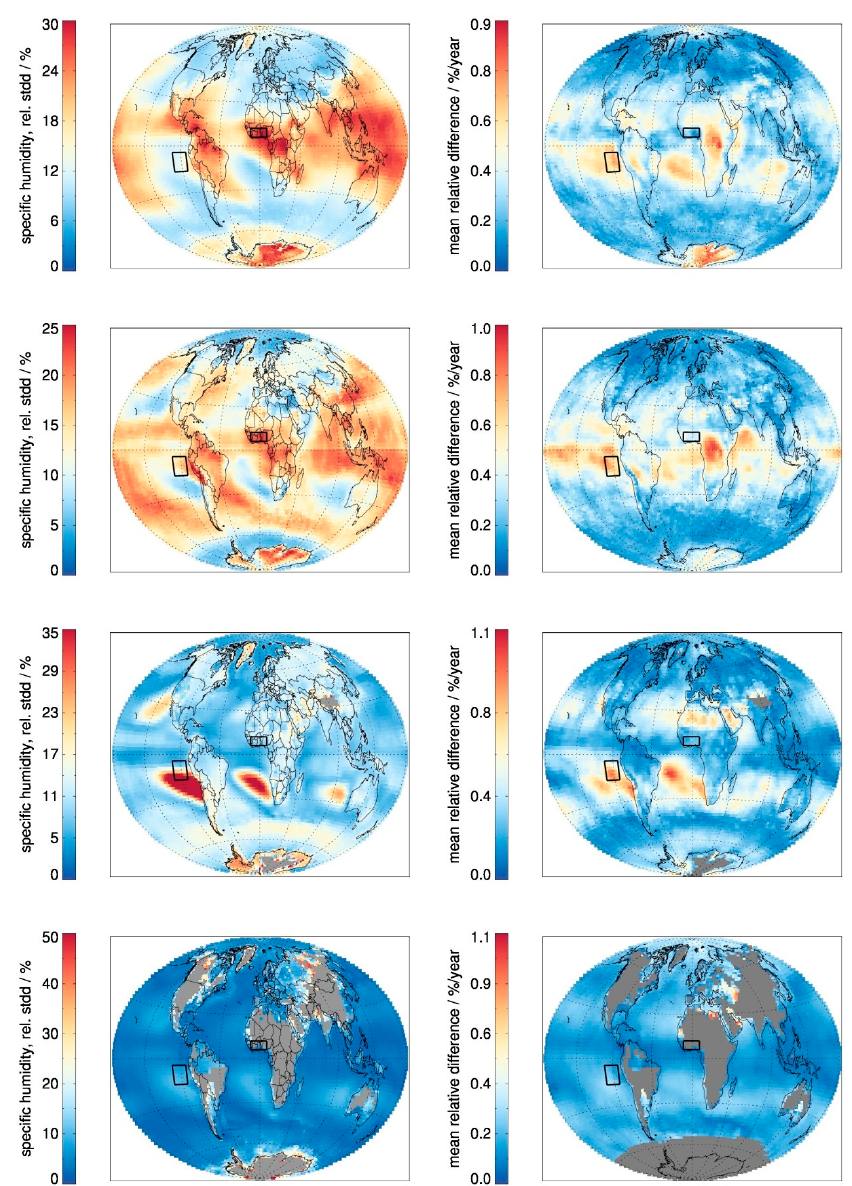
Figure 5. Ensemble mean relative standard deviation of specific humidity ( left column ) and mean relative differences of trend estimates of specific humidity ( right column ) at 300 hPa (top row), 500 hPa (second row), 700 hPa (third row) and 1000 hPa (bottom row). All panels have been computed using all seven q and T data records covering the period 1988–2009. The black boxes mark the stratocumulus region off the west coast of South America (Sc Pacific) and western Africa. Grey areas differ between left and right panels because the trends are estimated only if more than 75% of the monthly observations are valid.